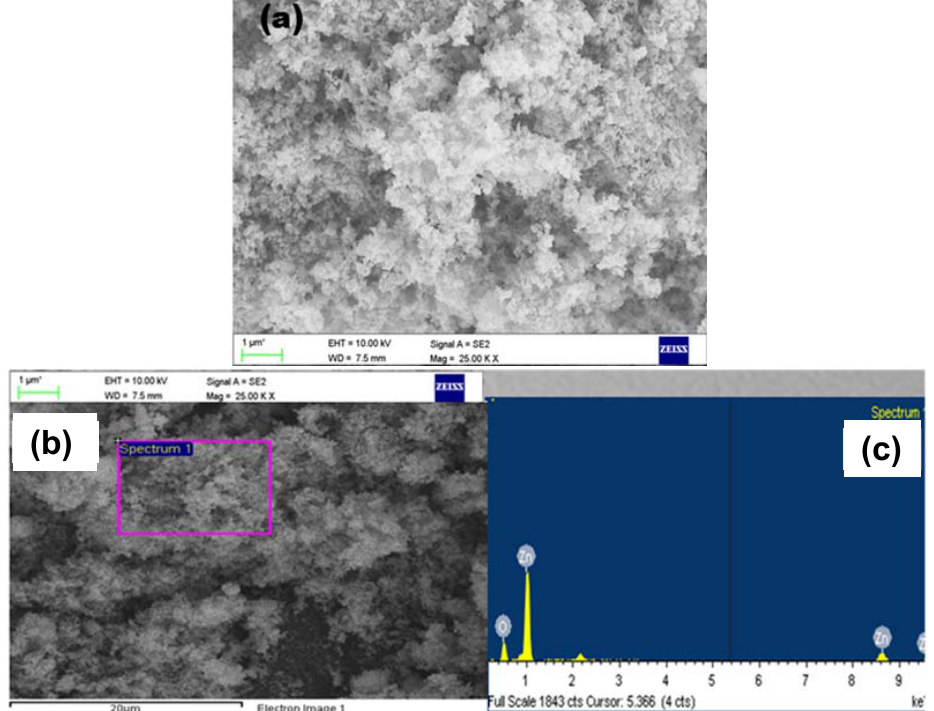
Fig. 2. (a) FESEM image, (b) SEM image and (c) EDS spectrum of ZnO nanoparticles